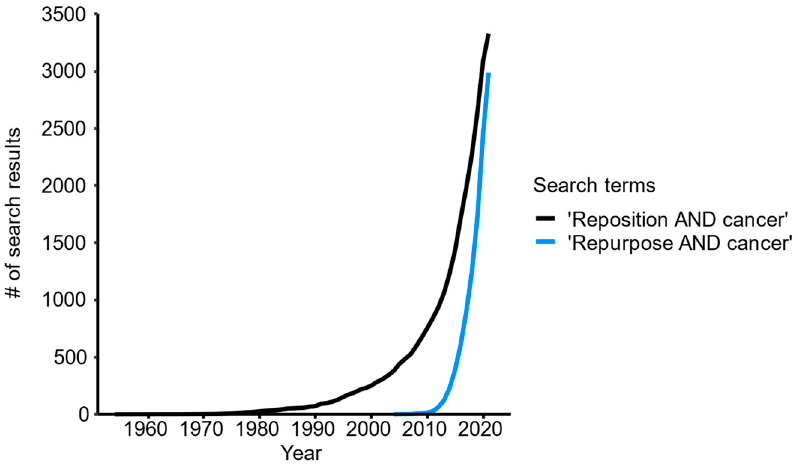
Figure 1. Total number (#) of publications identified in PubMed (https://pubmed.ncbi.nlm.nih.gov, accessed on 13 July 2021) with search terms “reposition AND cancer” or “repurpose AND cancer”.